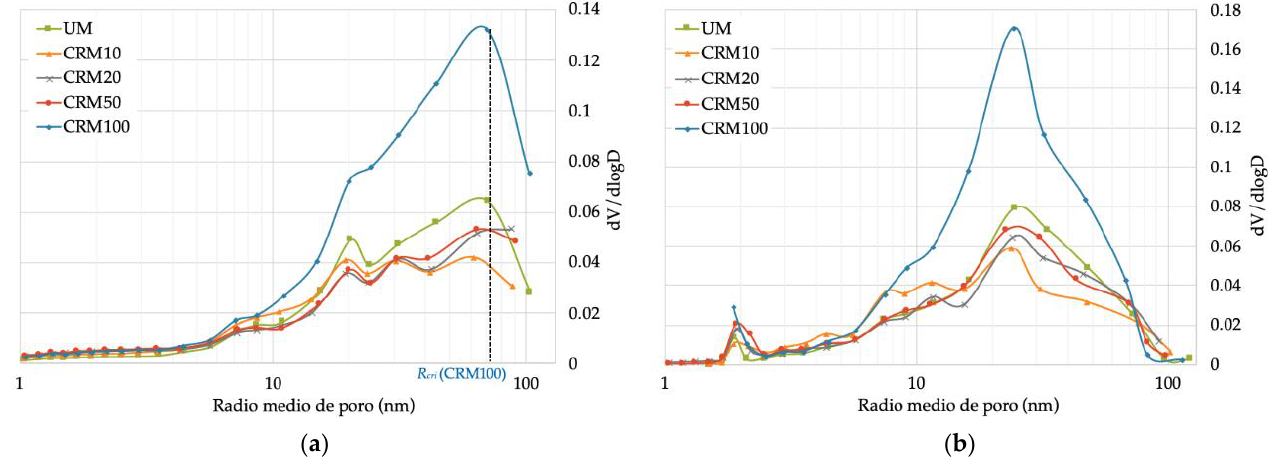
Figure 9. Pore radius with respect to pore volume differential: ( a ) adsorption phase; ( b ) desorption phase. For the properties of fm , E and density of the CRMs, it was established that the best fit was with the variable of rave porosity (in the adsorption phase); the type of fitting equation was that of a second-degree polynomial equation (see Figure 10). In this equation, the R 2 values and the equations for fitting the data for the three CRM properties are indicated, with a range of validity of application established between CRM10 and CRM100. In the three equations, the UM sample is isolated from the analysis, as it establishes inconclusive values for the study, which may have their origin in aspects inherent to the test or to its degree of precision (nm).